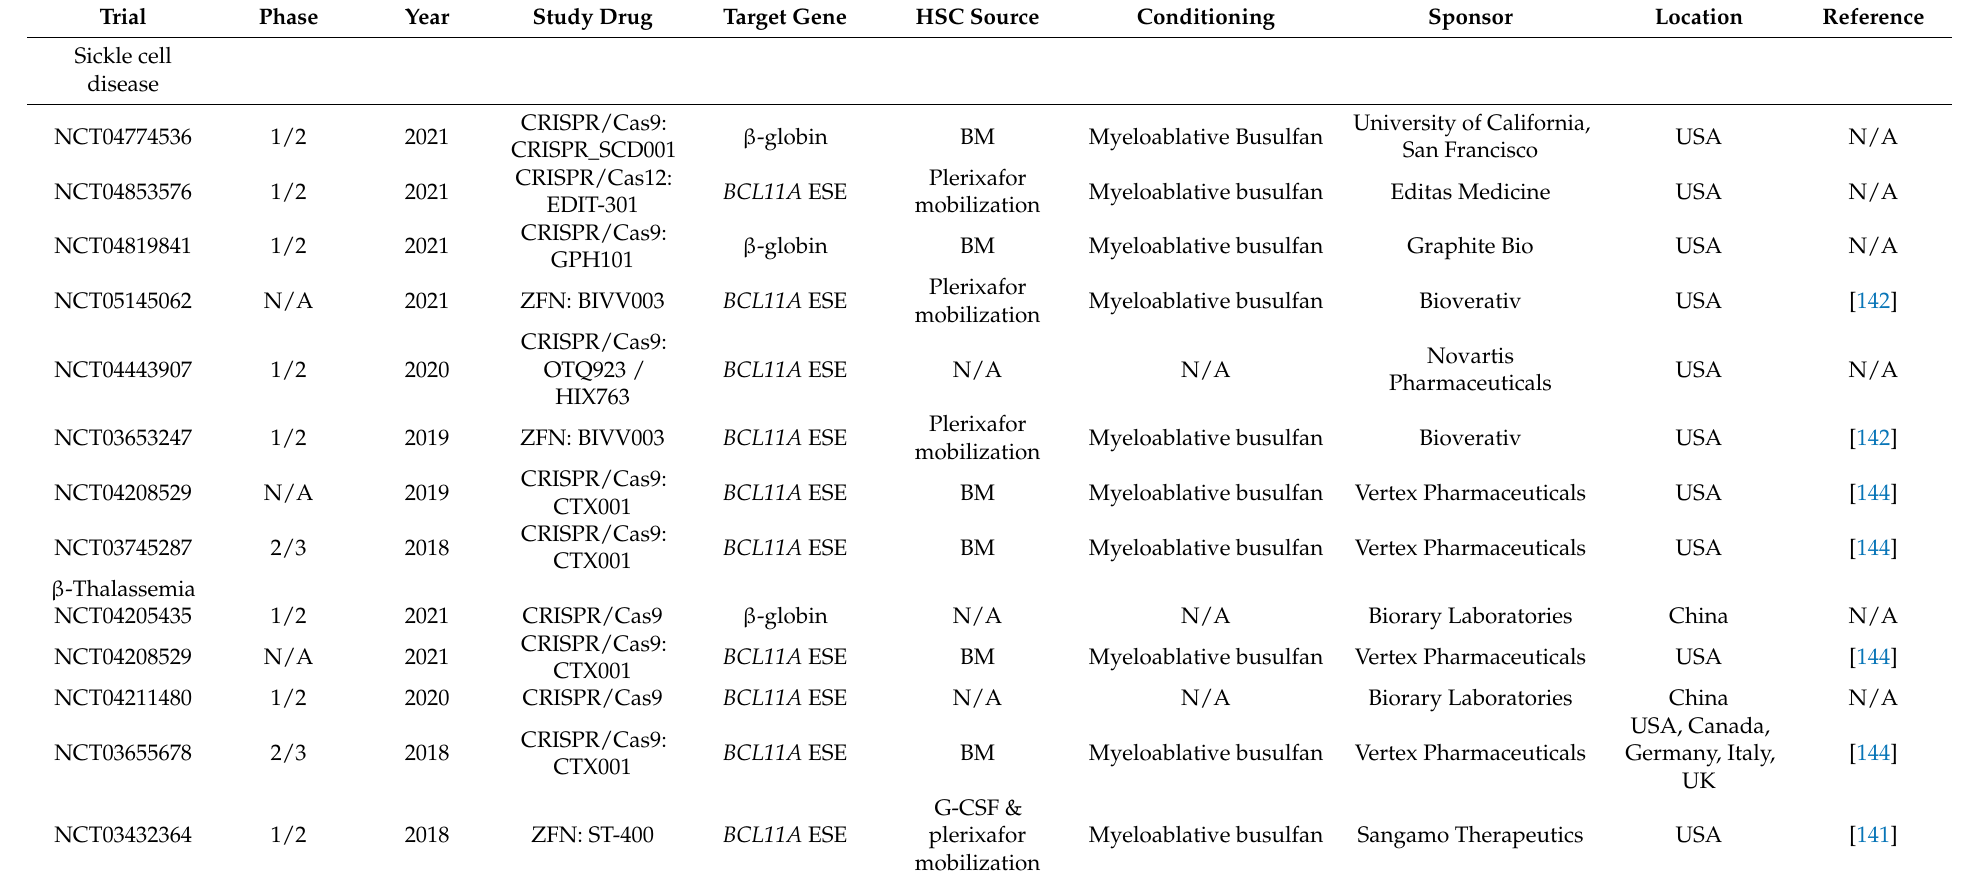
Table 2. A summary of HSC gene-editing therapy trials in SCD and